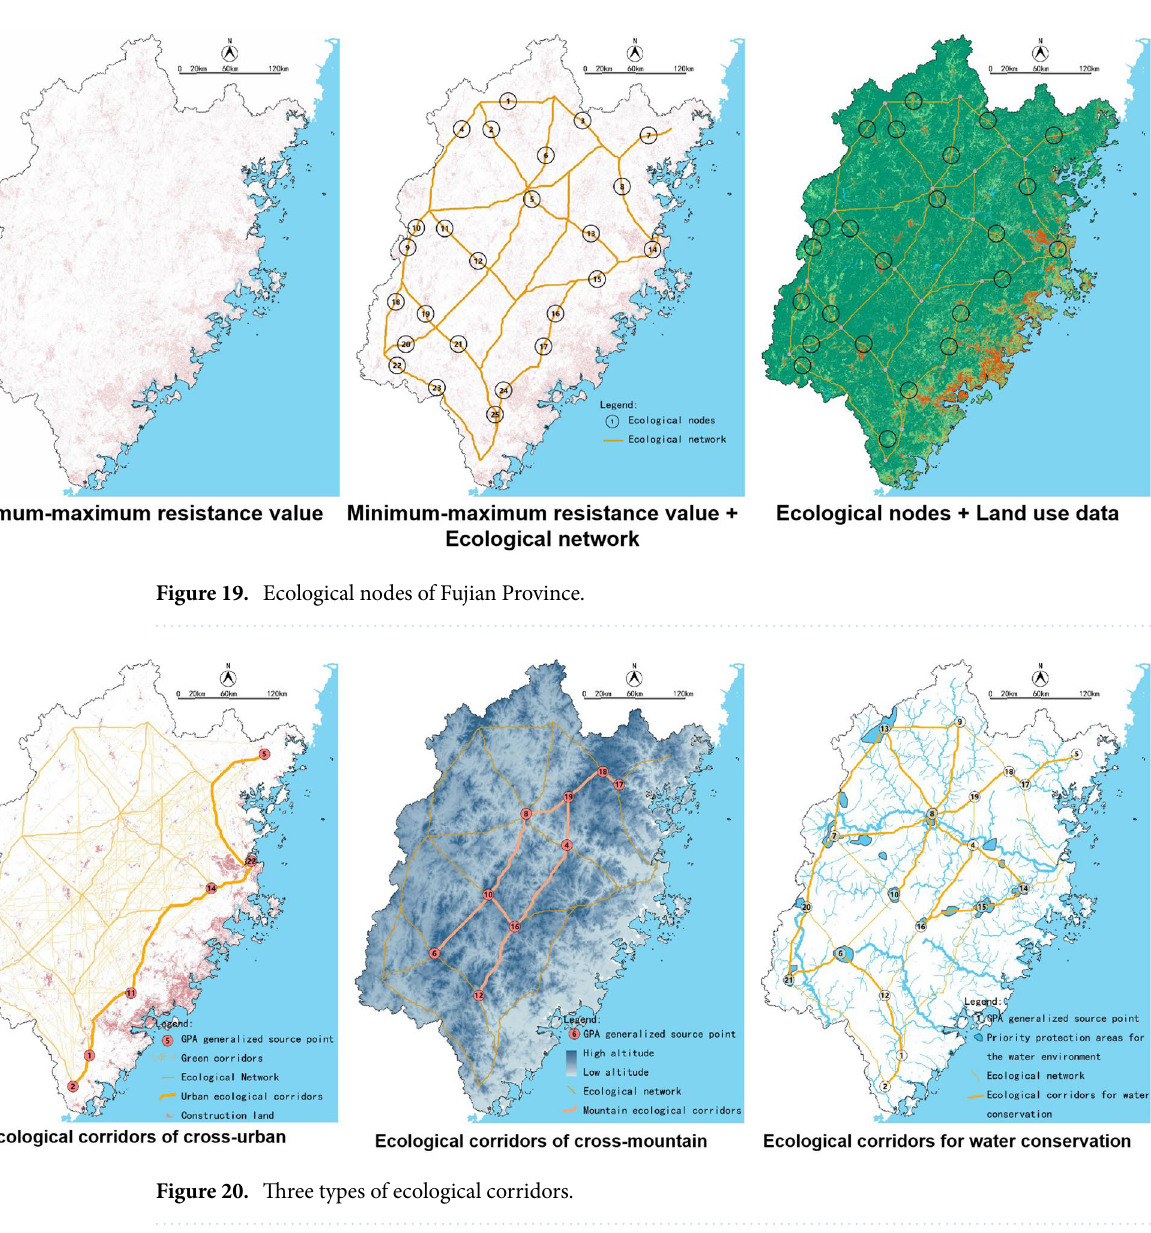
Figure 20. Three types of ecological